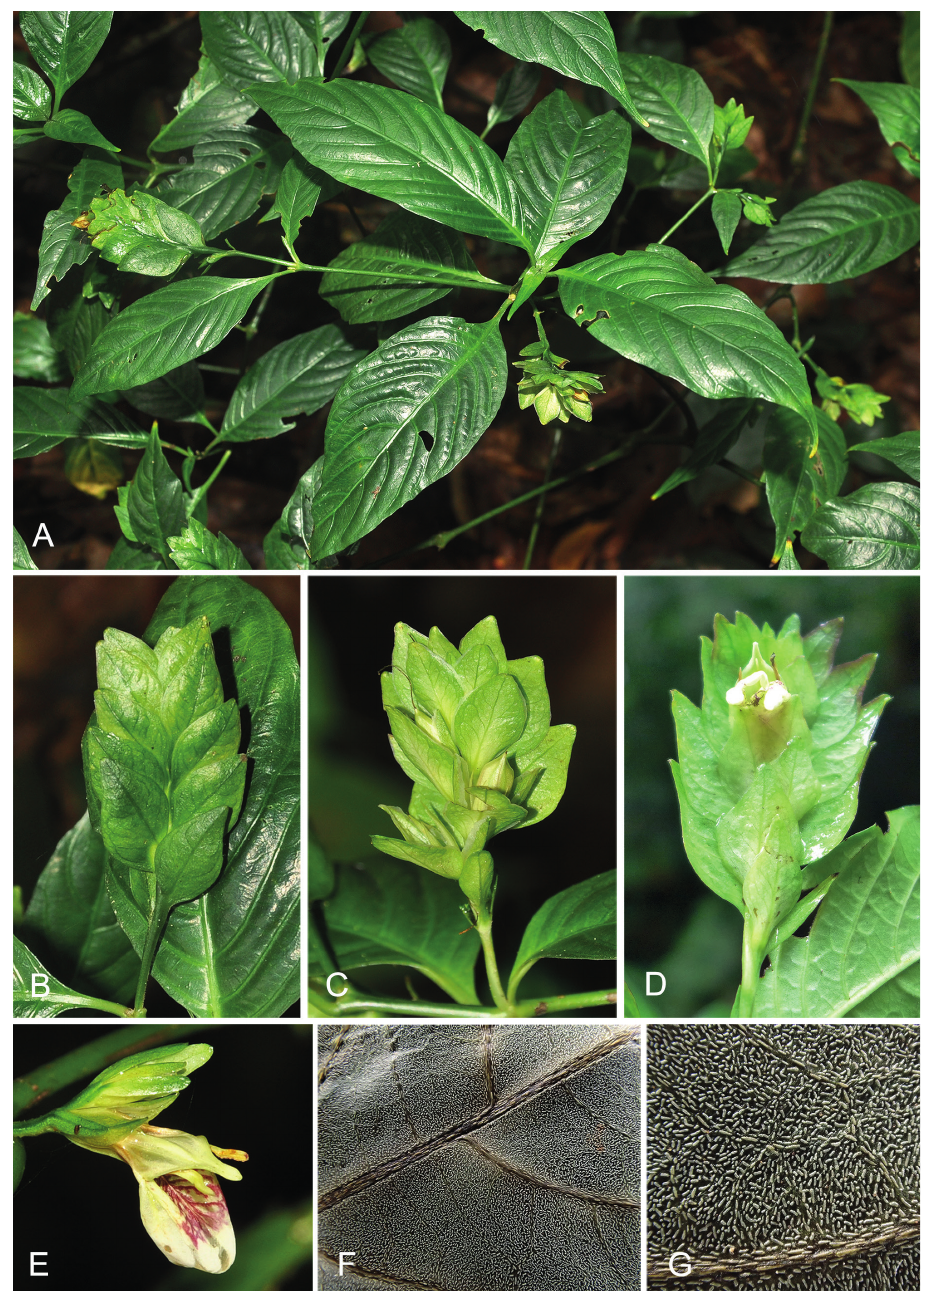
Figure 1. Photographs of Rungia fangdingiana sp. nov. A habit B spike (abaxial view showing the sterile bracts) C spike (adaxial view showing the fertile bracts and fruits) D spike (adaxial view showing the fertile bracts and corolla) E corolla F, G adaxial view of leaf blade (showing the linear cystoliths) A–E by Yun-Hong Tan, F , G by Zhe-Li